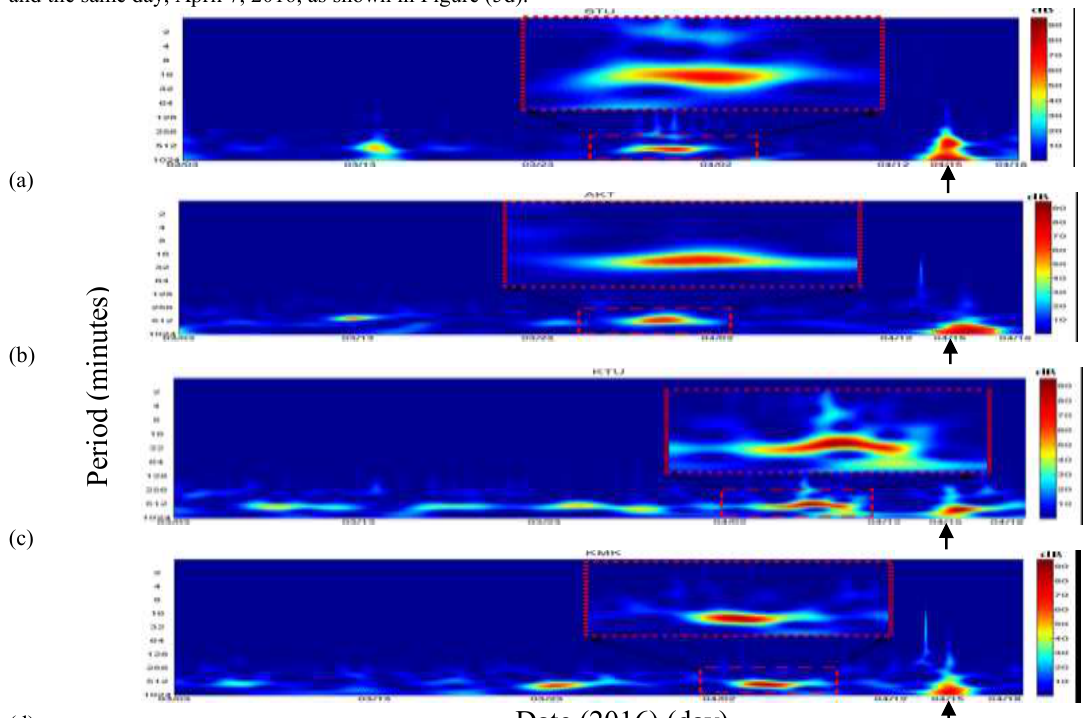
Figure 5 Wavelet analysis for longer-distance paths, (a) STU (b), AKT (c), KTU, and (d)